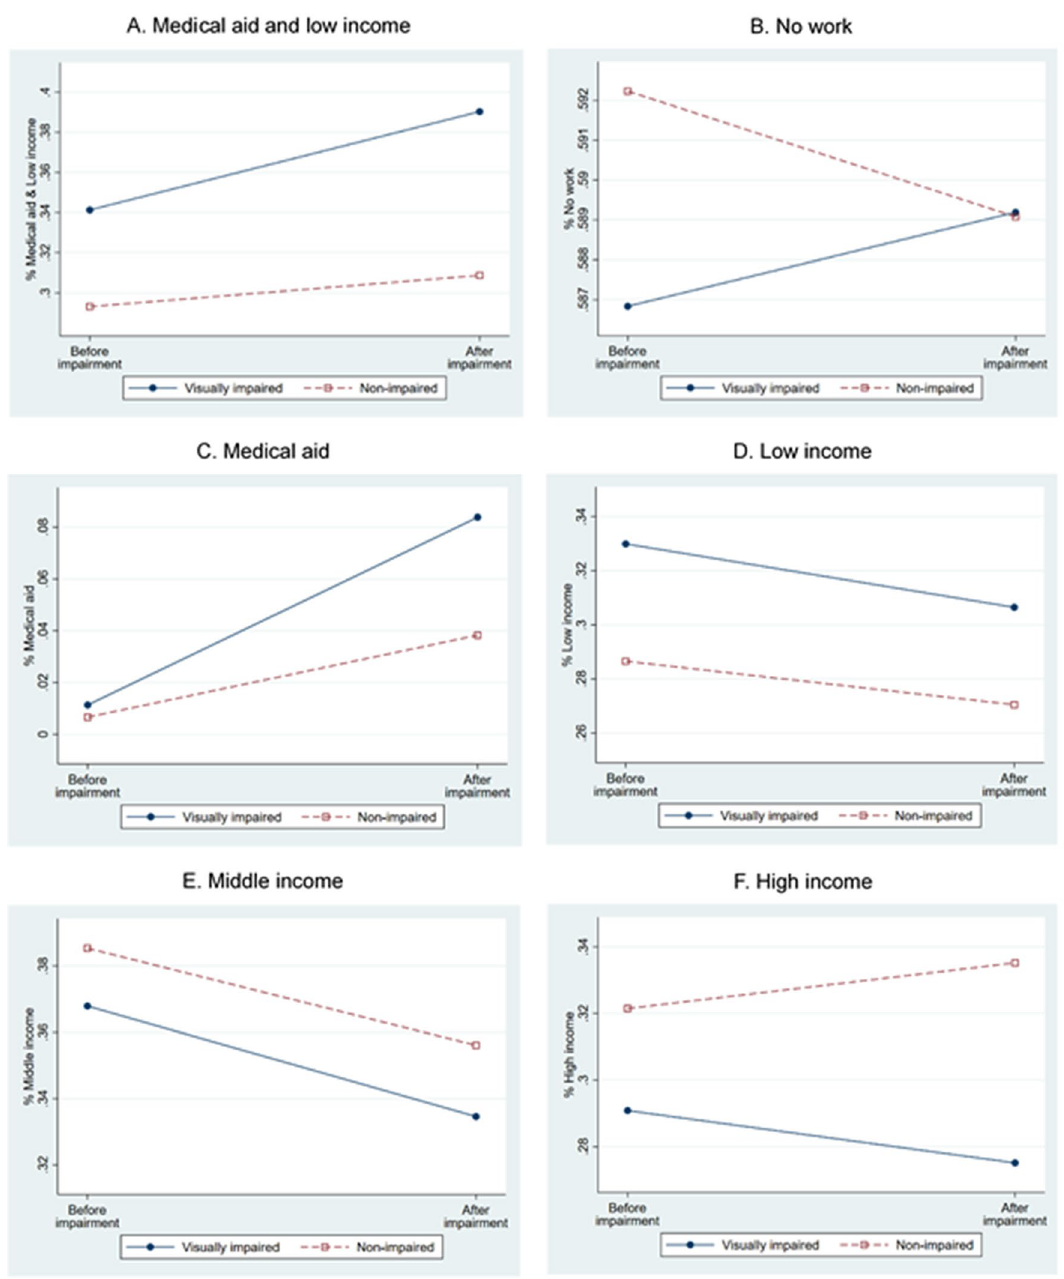
Figure 1. Proportion change of socioeconomic status by visual impairment. ( a ) Medical aid or low income; ( b ) No work; ( c ) Medical aid; ( d ) Low income; ( e ) Middle income; ( f ) High income. Each solid line represents for visually impaired and each dotted line represents for non-impaired. Each X axis denotes two time points, i.e., before and after visual